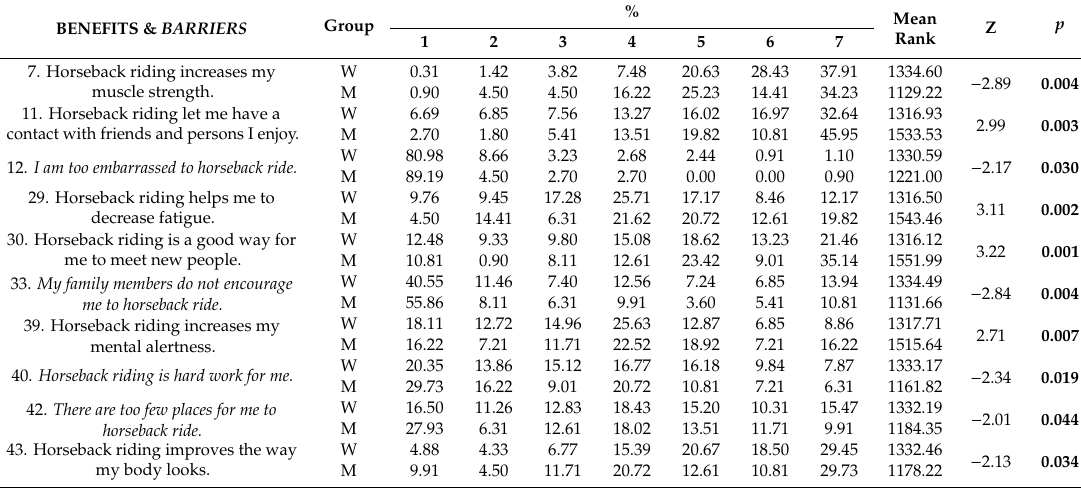
Table 4. Comparison of all respondents based on a gender: women (n = 2540) vs men (n = 111), ( p < 0.05). (1–7 Likert scale: 1—this issue concerns me to a very low degree; 7—this issue concerns me to a very high